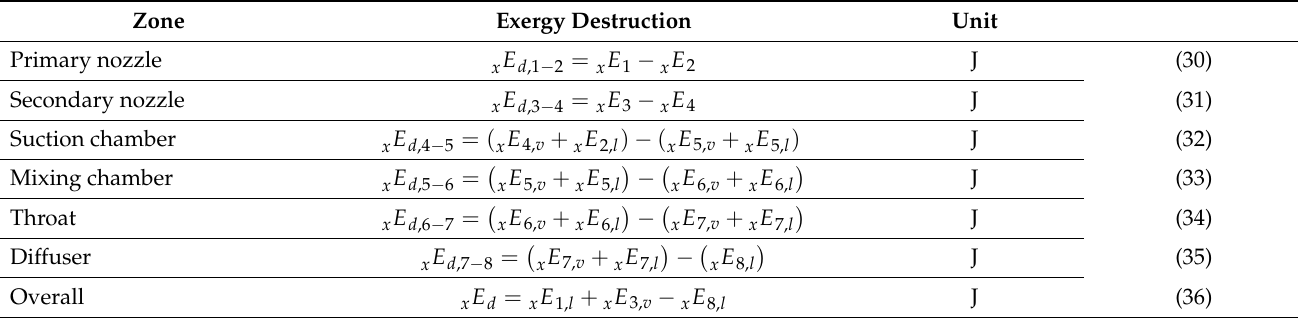
Table 3. Exergy destruction at various zones in